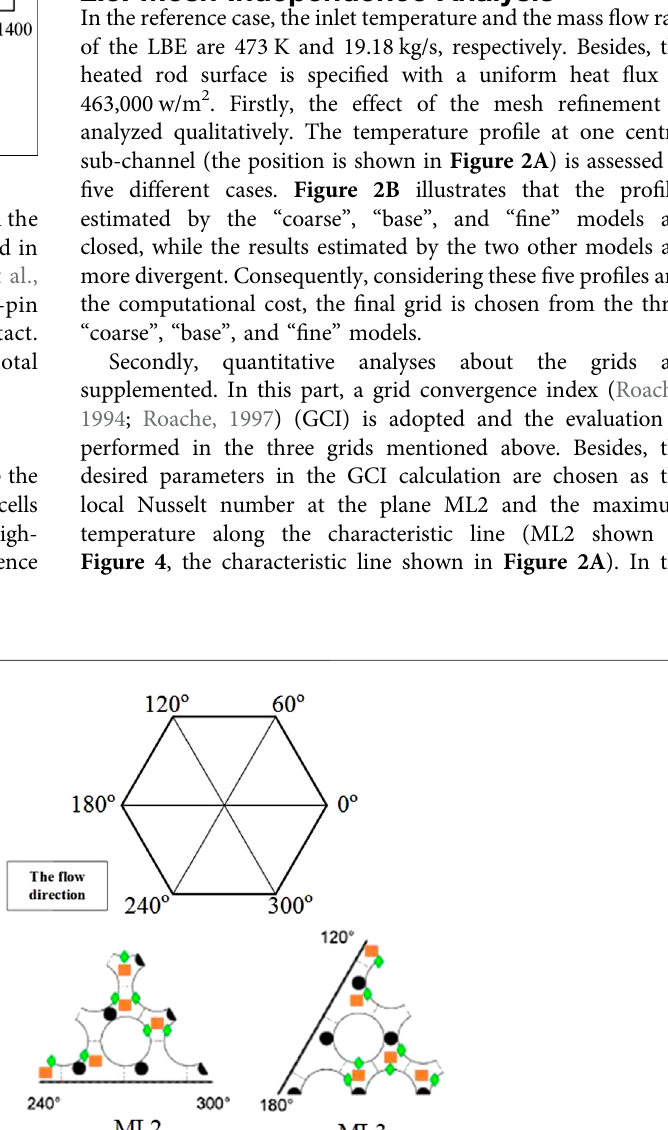
Frontiers in Energy Research |